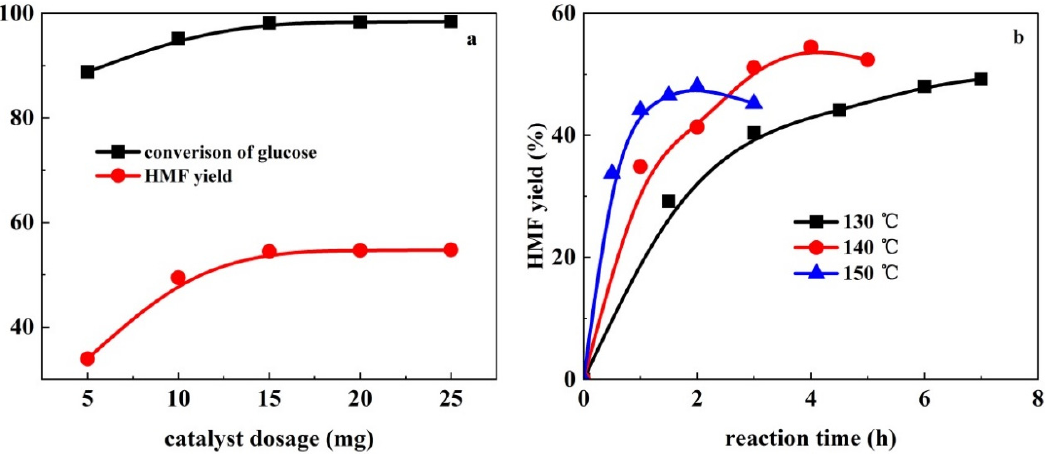
Figure 11. ( a ) Effect of catalyst dosages on glucose conversion and HMF yield; ( b ) Effect of reaction time under different temperatures on HMF production from glucose .